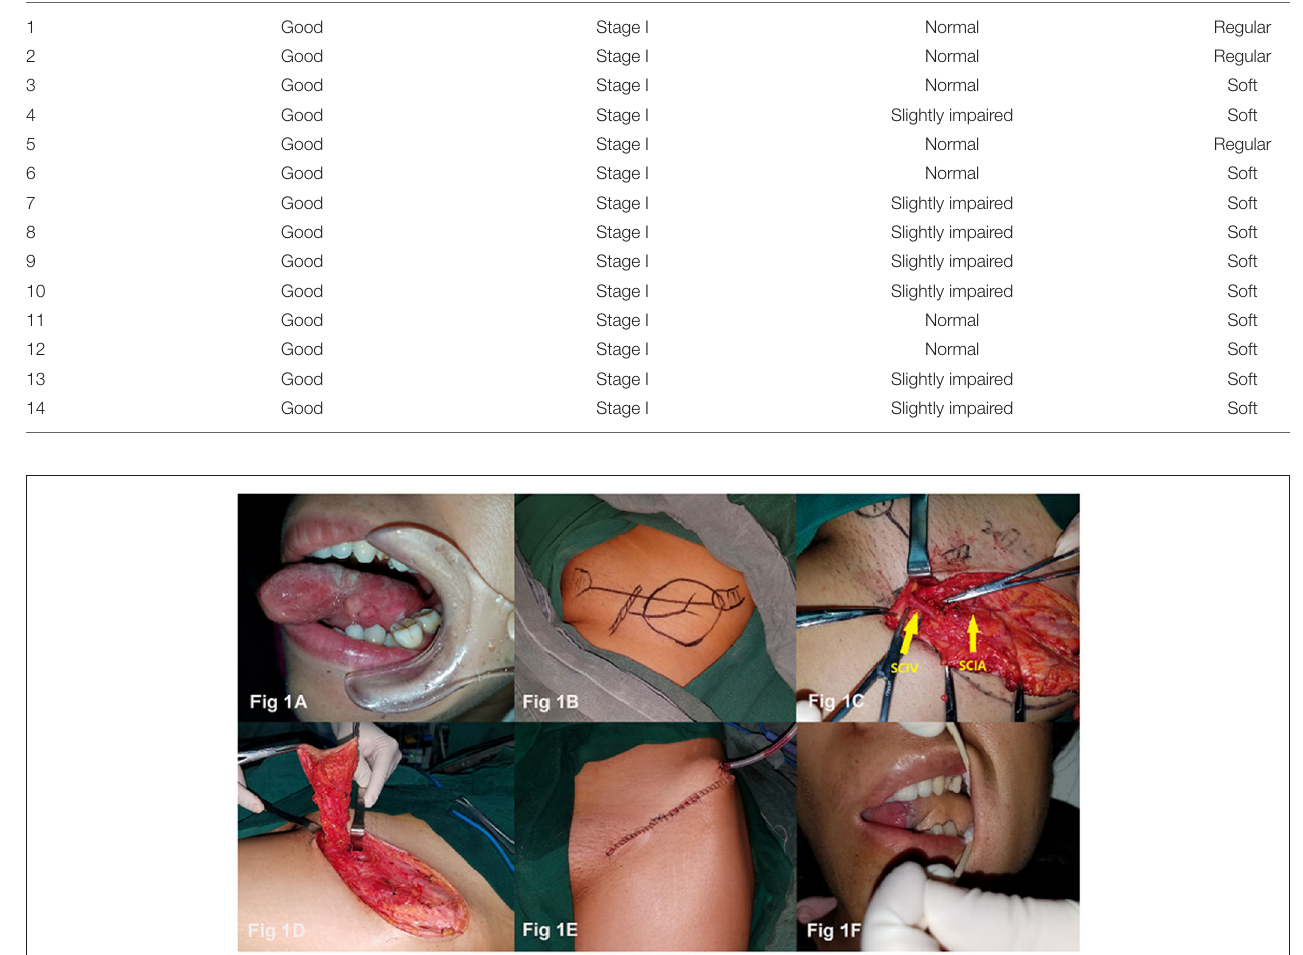
TABLE 3 | Functional evaluation of SCIP flap reconstruction after 6-month follow-up. Case